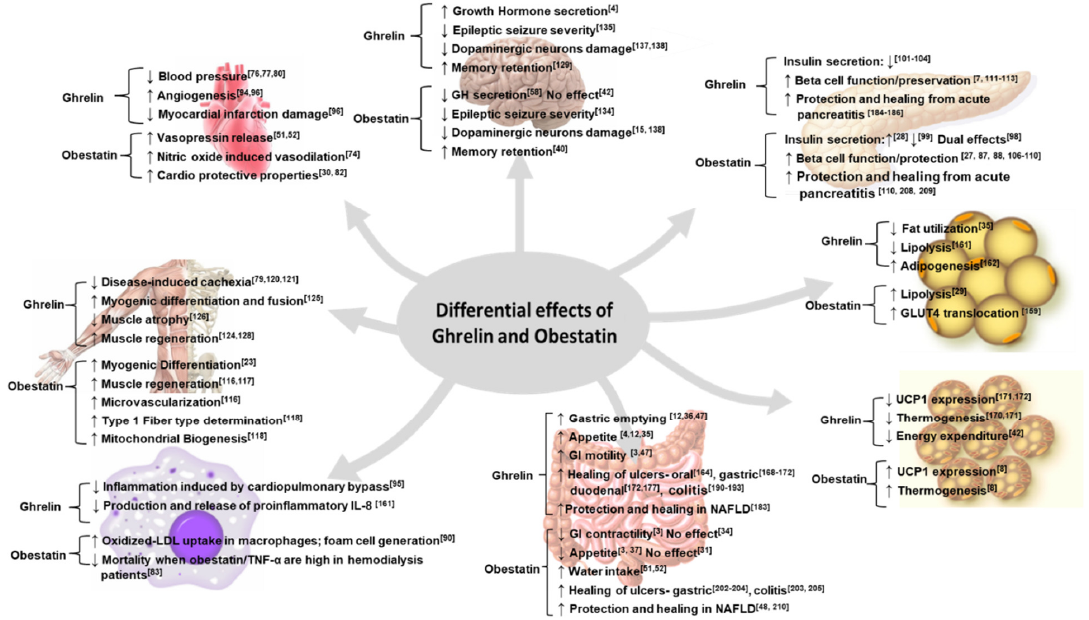
Figure 2. Summary of the differential effects of ghrelin and obestatin. ↑ denotes increase in function. ↓ denotes decrease in function. [3,4,7,8,12,15,23,27,28–31,34